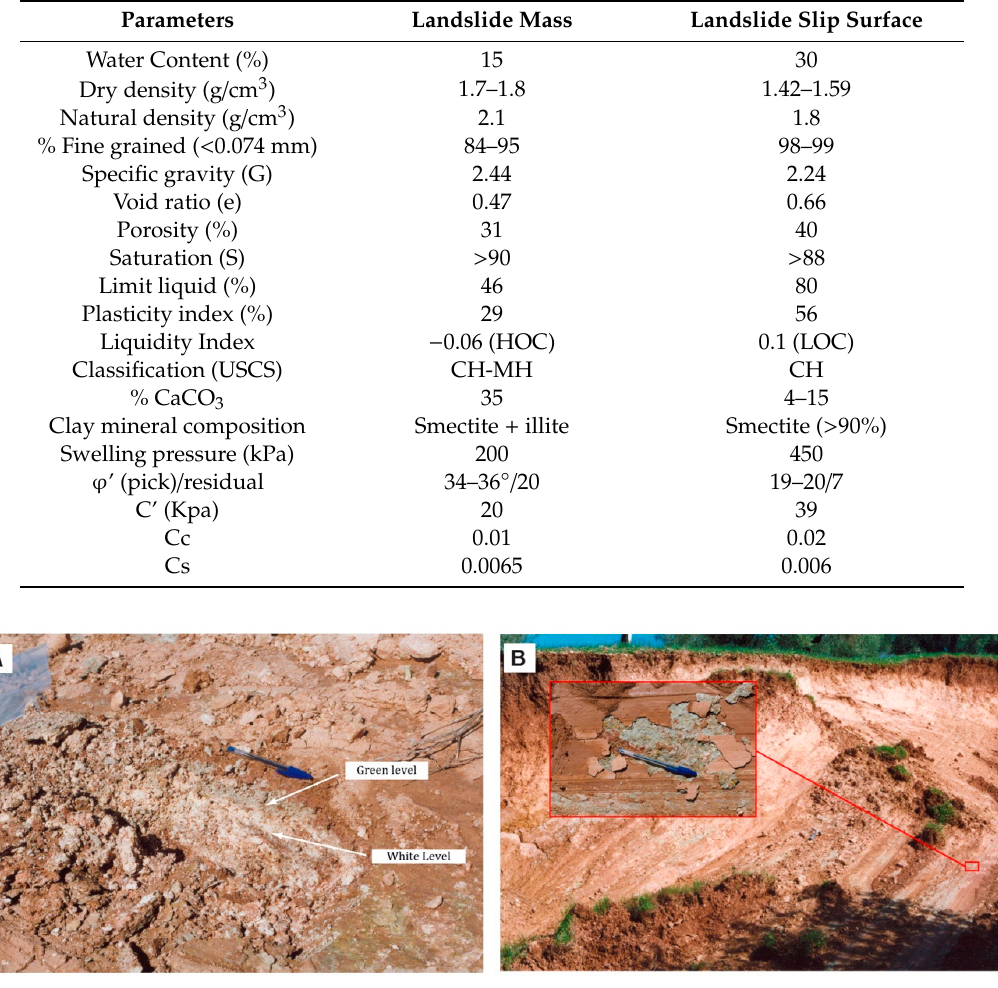
Table 1. Geotechnical properties of the materials involved in the Diezma landslide (modified from [11]). The table represents mean values on the 23 samples that have been analyzed on the landslide mass and 12 samples on the slip surface.